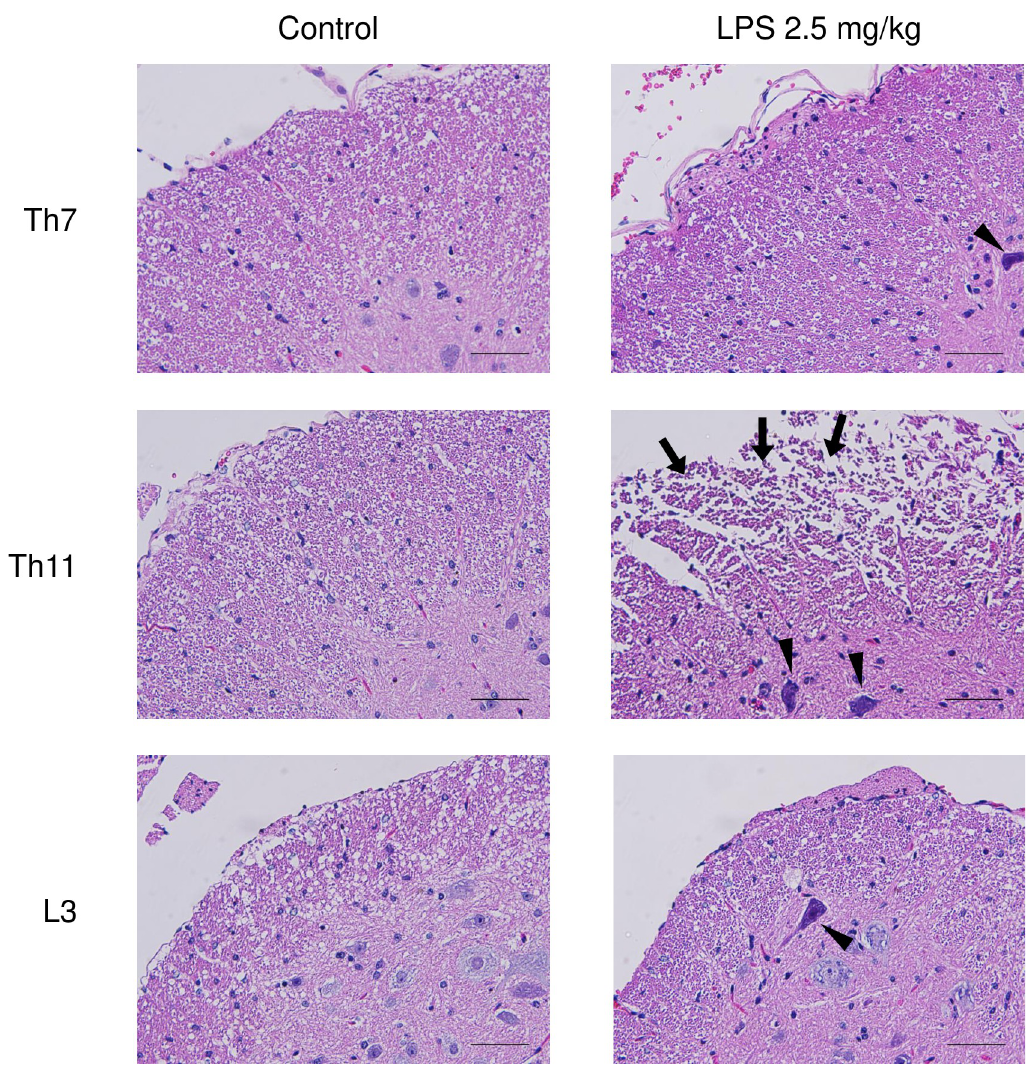
Fig 4. Histological changes in spinal cords after intraperitoneal LPS administration. High-magnification images of Fig 3 are shown. Arrows indicate edematous changes of the anterior column and arrowheads depict densely stained cells. Scale bars, 50 μ m ( ×